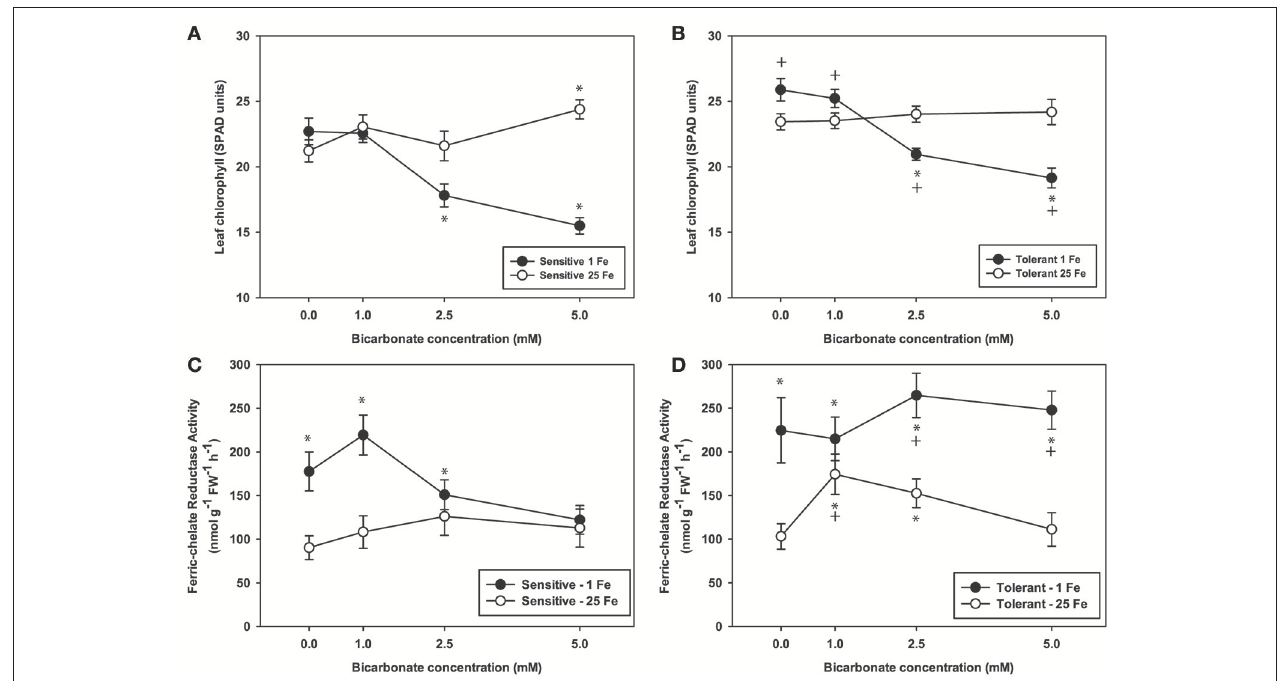
FIGURE 3 | Leaf chlorophyll and root ferric-chelate reductase activity in IDC tolerant and sensitive soybean plants. Plants were pretreated with 1 or 25 µ M Fe(III)-EDDHA for 6 d then treated with 1 or 25 µ M Fe(III)-EDDHA and 0, 1, 2.5, or 5mM sodium bicarbonate for 4 d. First trifoliate leaf chlorophyll (in SPAD units) in (A) IDC sensitive plants and (B) IDC tolerant plants. Root FCR activity in (C) IDC sensitive plants and (D) IDC tolerant plants. * indicates a significant difference ( p < 0.05) between treatment and control (25 Fe, 0 Bic). + in (B) and (D) indicates a significant difference between the tolerant and sensitive lines in that